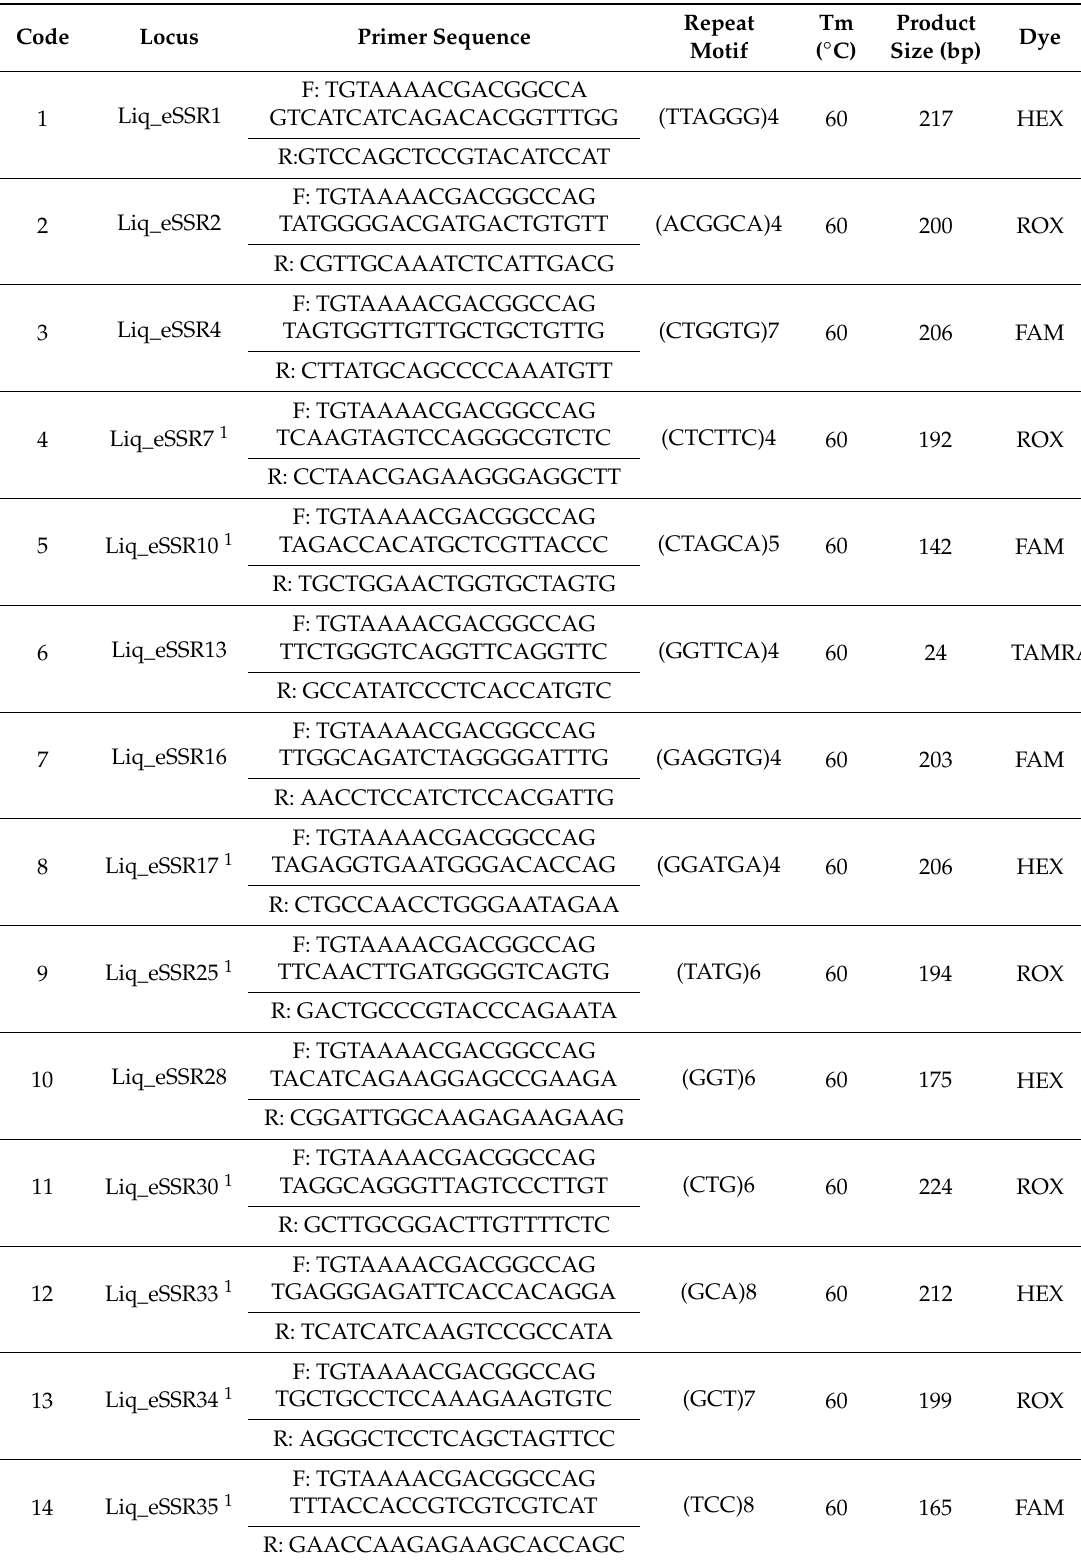
Table 3. Information on the 32 polymorphic SSR (simlpe sequence repeat) markers developed for L. formosana